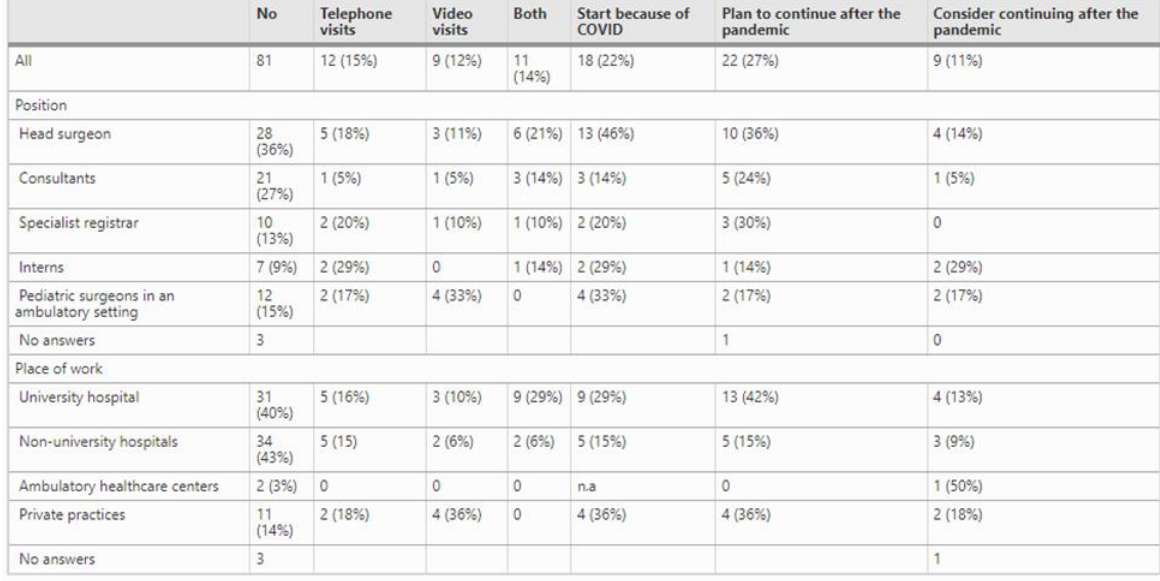
Figure 3. Telemedicine providence and professional features of research respondents (reprinted from Lakshin et al. [34]).